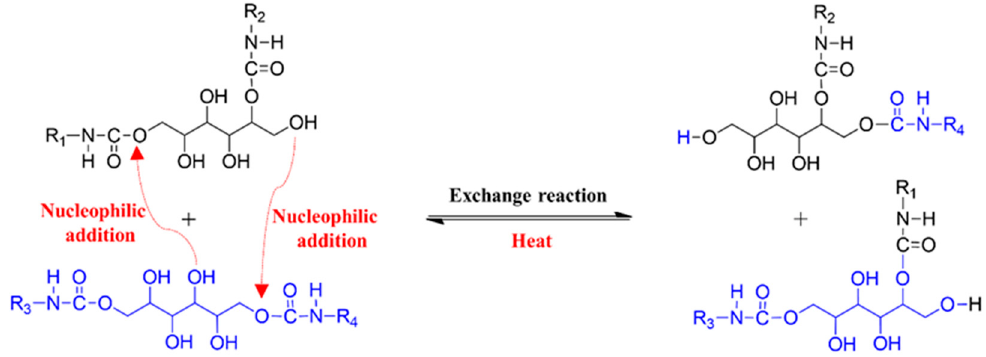
Figure 4. Schematic of the exchange reaction among the hydroxy urethane units of S-PU.